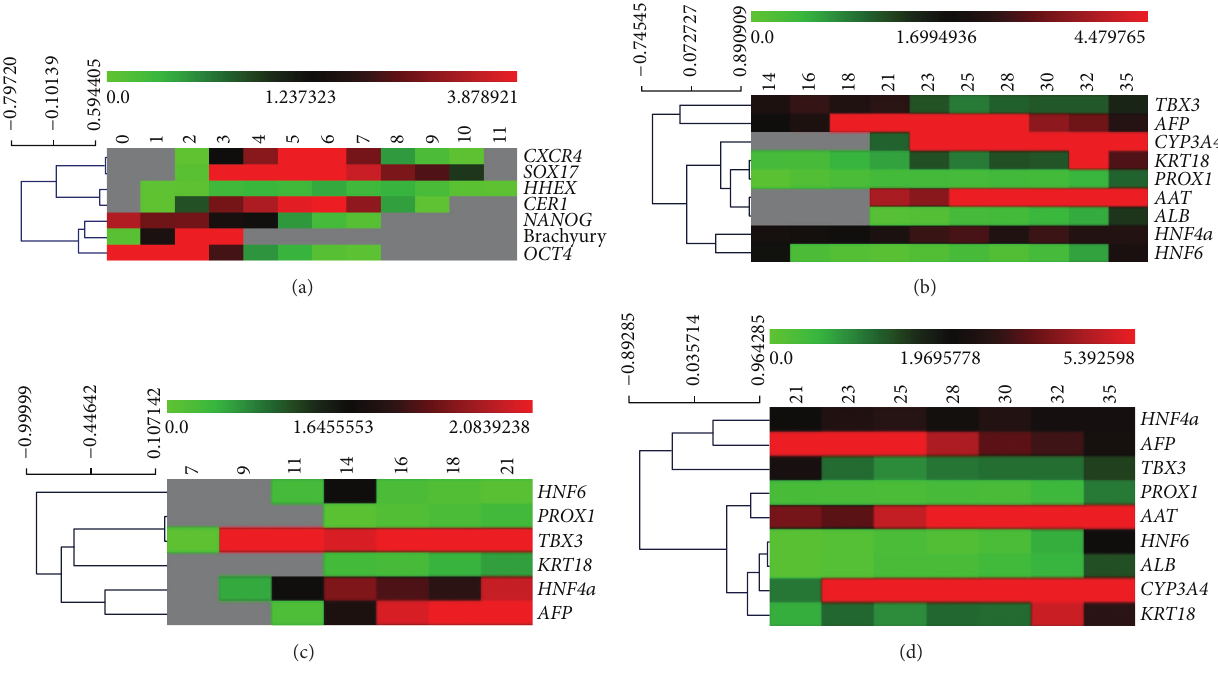
Figure 14: Clustering analysis. The genes included in the study were clustered applying Spearman rank correlation. Colors indicate RQ according to the scale shown above each heatmap. Missing values are indicated by gray color. (a) Clustering results for days 0 to 11, (b) days 14 to 35, (c) days 7 to 21, and (d) days 21 to